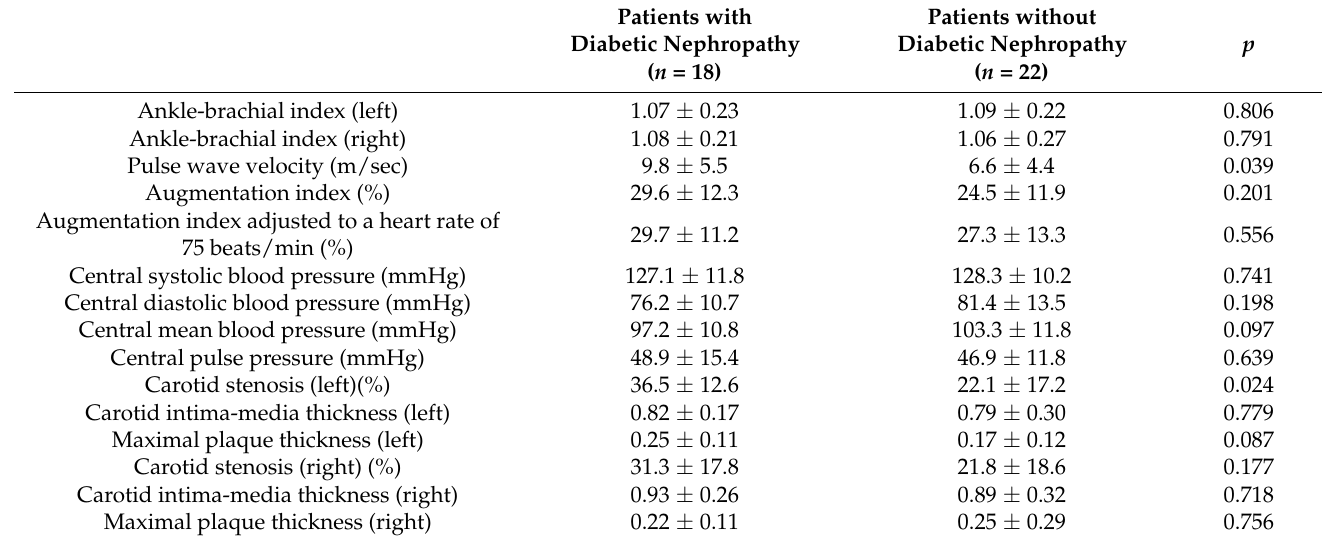
Table 2. Markers of subclinical vascular disease in patients with diabetic nephropathy and in patients without diabetic nephropathy (data shown are mean ±